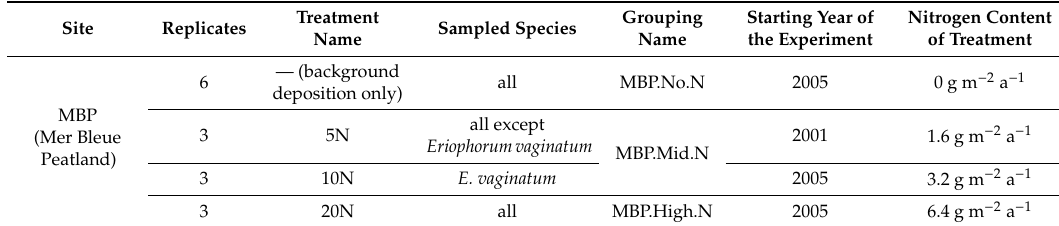
Table 1. Nitrogen fertilization rates and background wet nitrogen deposition at the Mer Bleue peatland experimental site. MBP: Mer Bleue Peatland. Treatment names are based on [26].